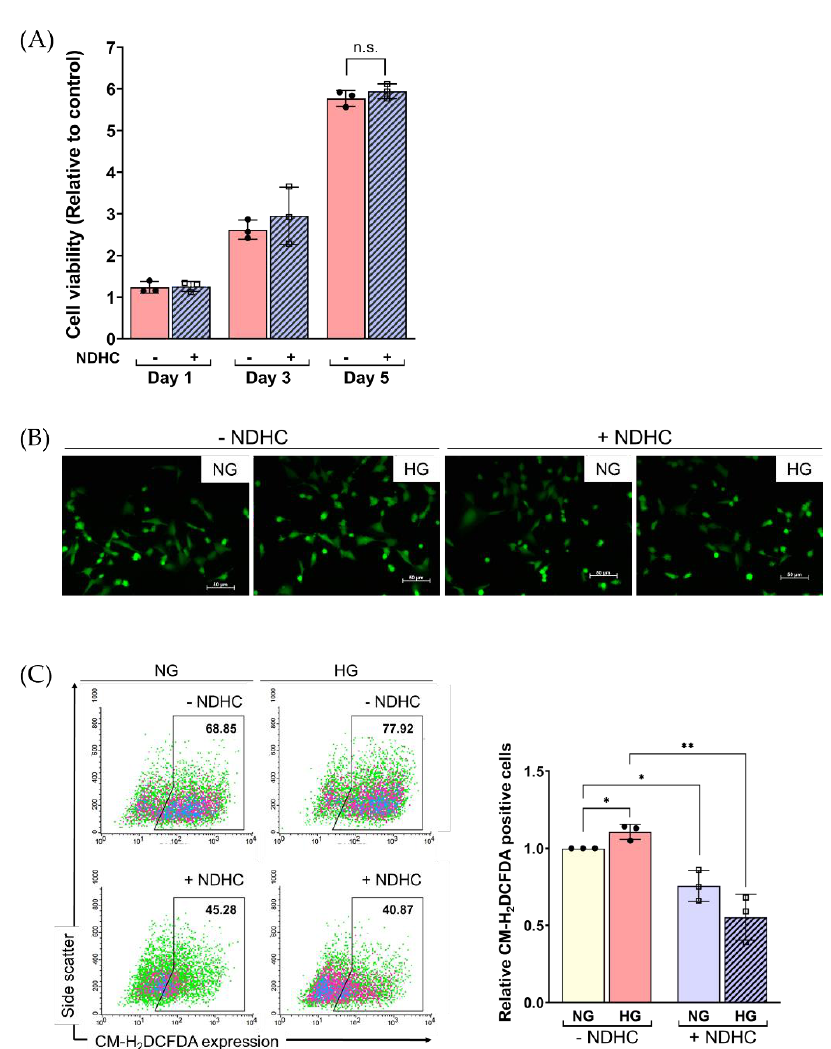
Figure 4. Effect of NDHC pretreatment on the viability of HLE and ROS production under high- glucose conditions. ( A ) The viability of HLE cell either pretreating with or without 10 µM of NDHC before exposure to 5.5 mM (NG) or 55.5 mM (HG) glucose for various lengths of time (Day 1, 3, 5) was evaluated by Alamar blue assay. ( B ) ROS expression was quantified by probing with chloromethyl derivative of 2 ′ ,7 ′ -dichlorodihydrofluorescein (CMH 2 DCFDA). The green-stained cells were observed from a fluorescence microscope. ( C ) Quantitative analysis of the CMH 2 DCFDA-stained cell was obtained using flow cytometry. Data are representative of 3 independent experiments (mean ± SD). * p < 0.05, ** p < 0.01, n.s. = not significant.